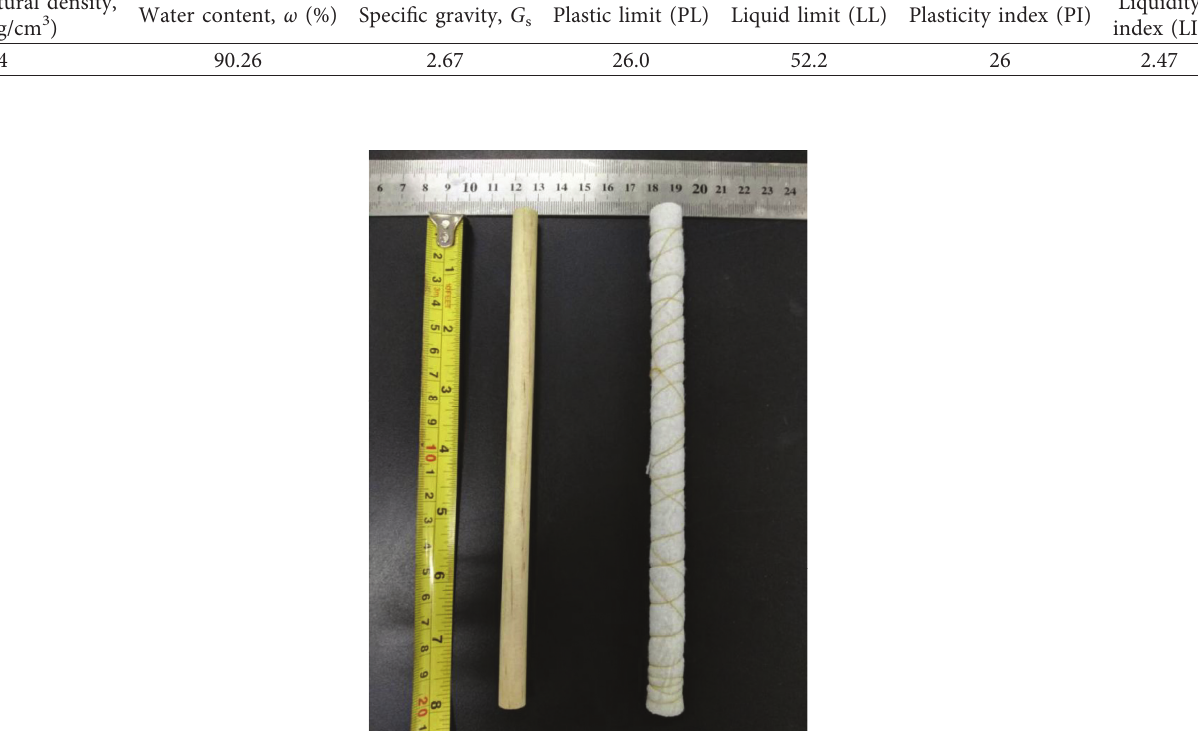
Natural density, ρ (g/cm 3 )